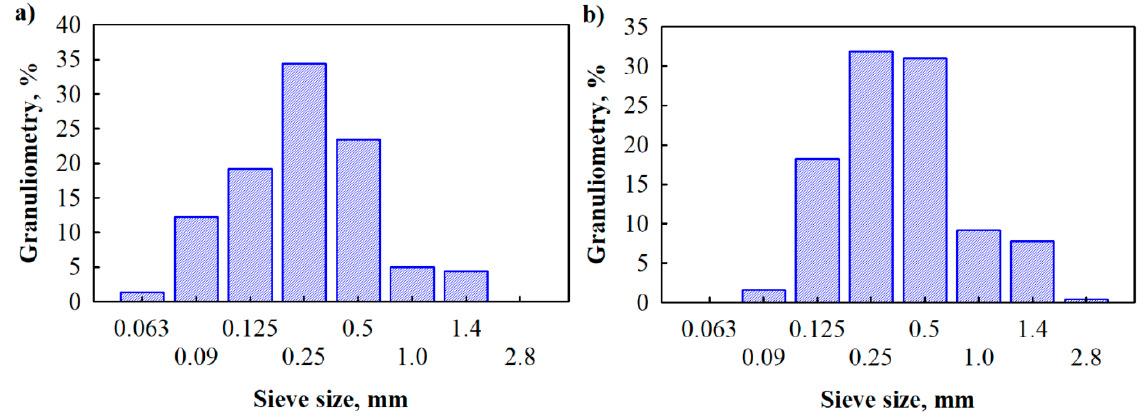
Figure 2. Granuliometric composition of: ( a ) SFP particles and ( b ) LG-SFP particles.